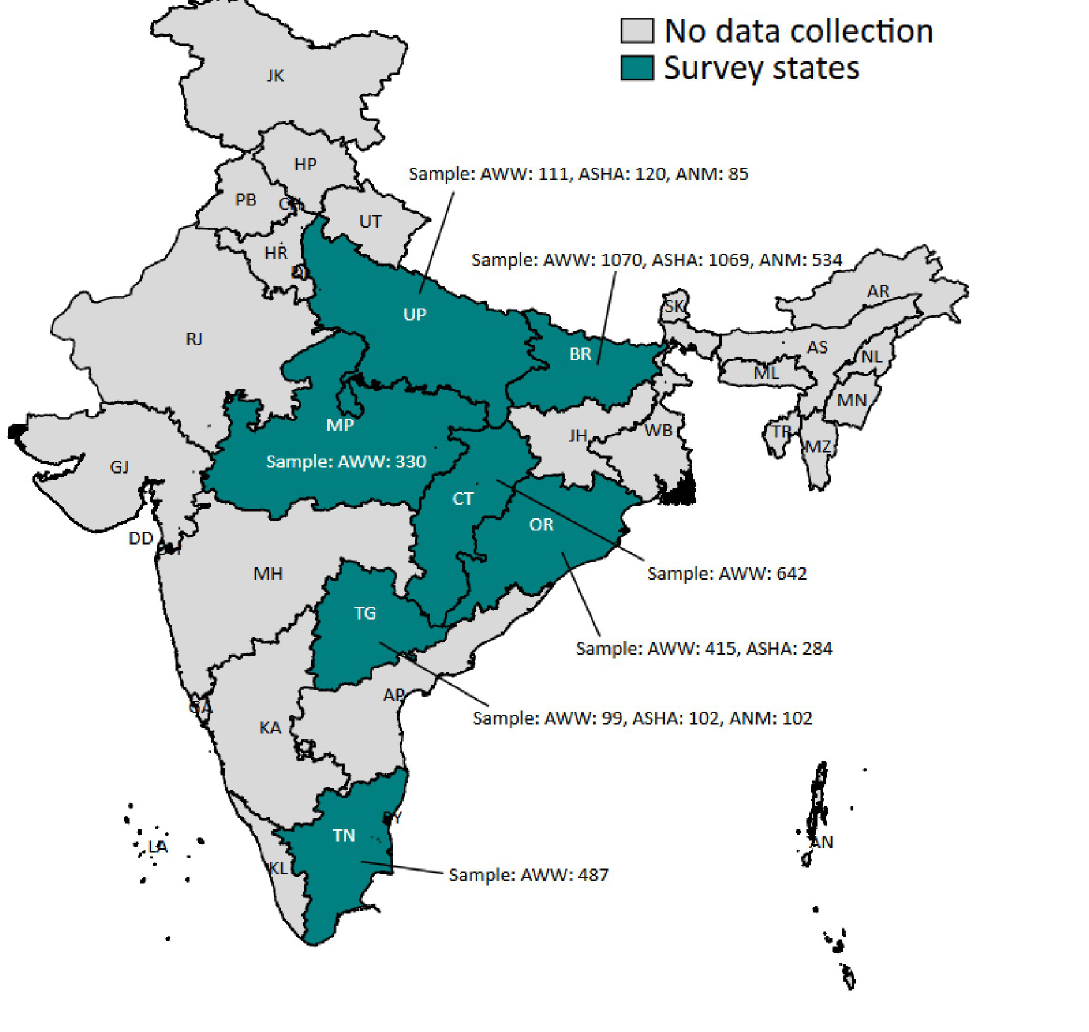
Fig 1. Phone survey in India: State and sample size. ANM: Auxiliary Nurse Midwife, AWW: Anganwadi Worker, ASHA: Accredited Social Health Activist. BR: Bihar, CG: Chhattisgarh; MP: Madhya Pradesh; OR: Odisha; TG: Telangana; TN: Tamil Nadu; UP: Uttar